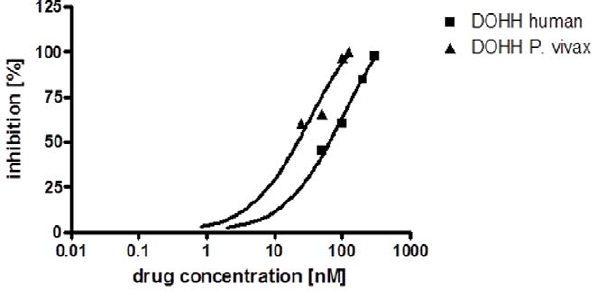
Figure 6. Dose response curves of zileuton obtained after inhibition of DOHH from P. vivax and P. falciparum. Different zileuton concentratons from 5 to 300 nmol were applied. The percentage of inhibiton was plotted against the different drug concentrations. The dose-response curve of P. vivax DOHH is presented in triangles and that for human DOHH in squares.